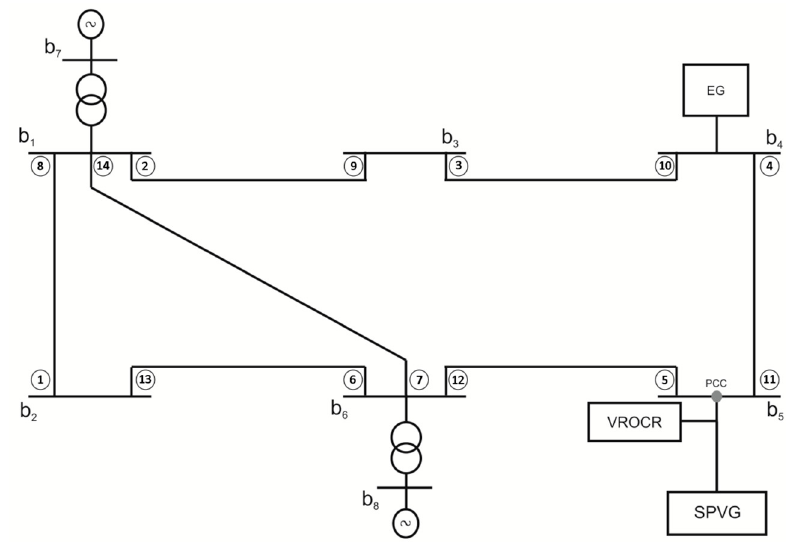
Figure 2. Diagram of SPVG-connected 8-bus system.